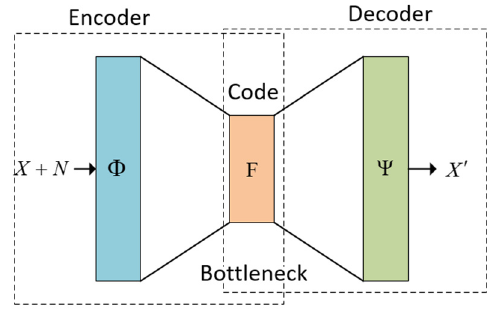
Figure 1. The autoencoder structure.